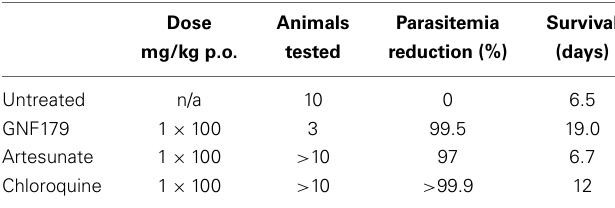
Table 1 | Parasitemia reduction and survival in a Plasmodium Berghei mouse model of Malaria infection (Meister et al., 2011). Dose Animals Parasitemia Survival mg/kg p.o. tested reduction (%)